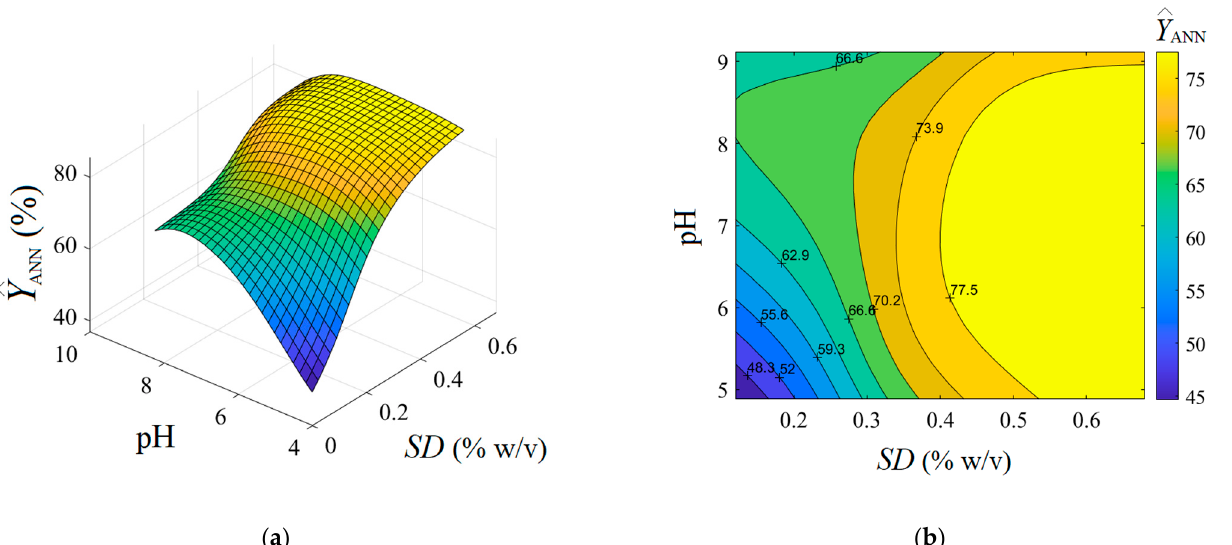
^ (cid:3002)(cid:3015)(cid:3015) )